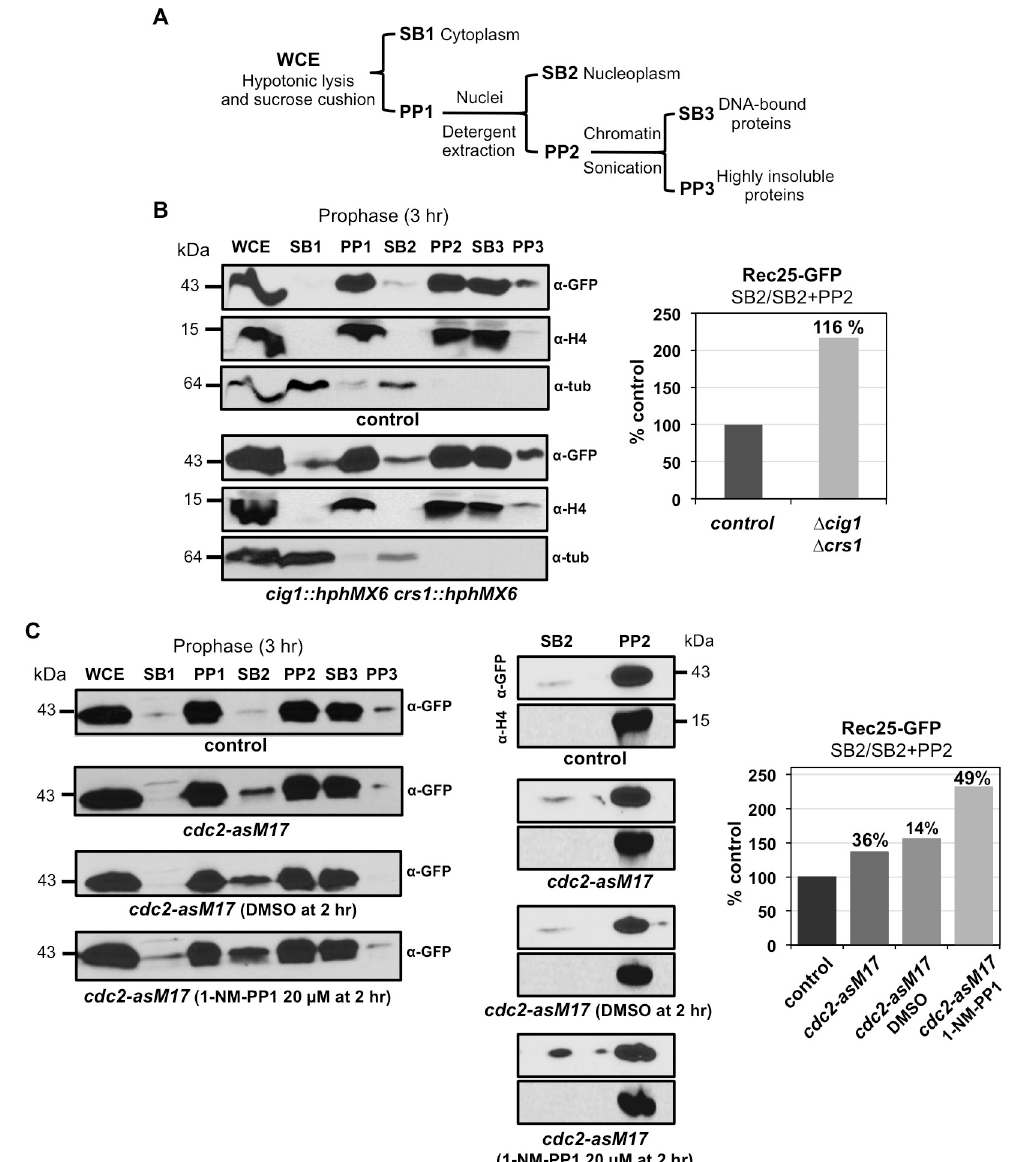
Fig 7. CDK down-regulation reduces chromatin binding of the LinE-component Rec25. Synchronous diploid pat1-114 rec25-GFP meiosis were induced and cells collected in prophase for cellular fractionation following the scheme shown in (A) . (B) Rec25-GFP chromatin binding is reduced in double cig1 crs1 deletion mutants. Synchronous diploid pat1-114 rec25-GFP meiosis of control (CMC78) and double cig1 crs1 deletion mutants (CMC1207) were induced and cells collected after 3 hr for cellular fractionation. On the left Western blot analysis of the different fractions. The distribution of Rec25-GFP protein was followed with anti-GFP antibodies. The same membranes were used to analyze the distribution of the Histone H4 and Tubulin as controls. Each lane contains equal extract equivalents (7% of WCE). On the right Quantification of Rec25-GFP recovery after detergent treatment of the nuclear fraction (SB2/SB2+PP2), expressed as the percentage relative to the control strain. For quantification only SB2 and PP2 fractions were loaded in a new gel leaving an empty lane in between to avoid sample mixing by diffusion. Similar result (increased Rec25-GFP solubilization, 1.66 fold) was obtained in an independent experiment. Quantification in WCE of Rec25-GFP normalized to histone H4 indicates similar Rec25-GFP levels in control and cig1 crs1 mutant cells (ratio control/mutant 0.96 in the experiment shown, and 1.13 in the second independent experiment). (C) Chemical inhibition of Cdc2 reduces Rec25-GFP chromatin binding (CDK inhibition after DNA replication). Synchronous diploid pat1-114 rec25-GFP cdc2-asM17 meiosis (CMC1192) were induced, DMSO or 20 μ M 1-NM-PP1 added at the end of S-phase (at 2 hr), and cells collected for cellular fractionation 1 hr later (at 3 hr after meiotic induction). As additional controls, untreated cdc2-asM17 cells and a cdc2 + strain (CMC78) were also analyzed. On the left Western blot analysis as in B of the different fractions. On the right Quantification of